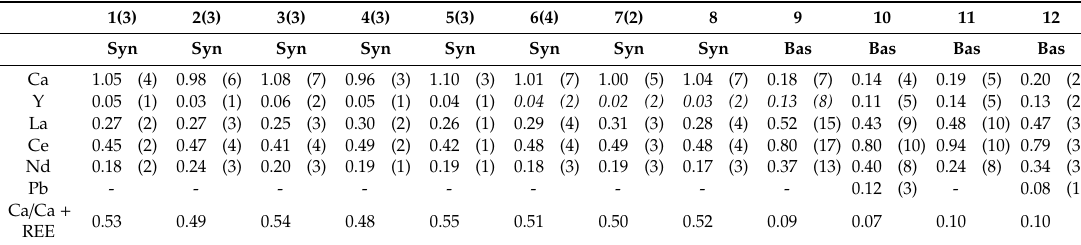
Table 3. TEM-EDS Analysis of (Ca,REE)-Fluorcarbonates from Cinquevalli (Trento, Italy). Each Column Refers to a Single Grain (if not a Single Spot Analysis, the Number of Averaged Analyses is Indicated in Brackets). Atoms are Calculated on the Basis of Two Cations in the Chemical Formula. Relative Error in Brackets (Values in Italics when Below 2 σ